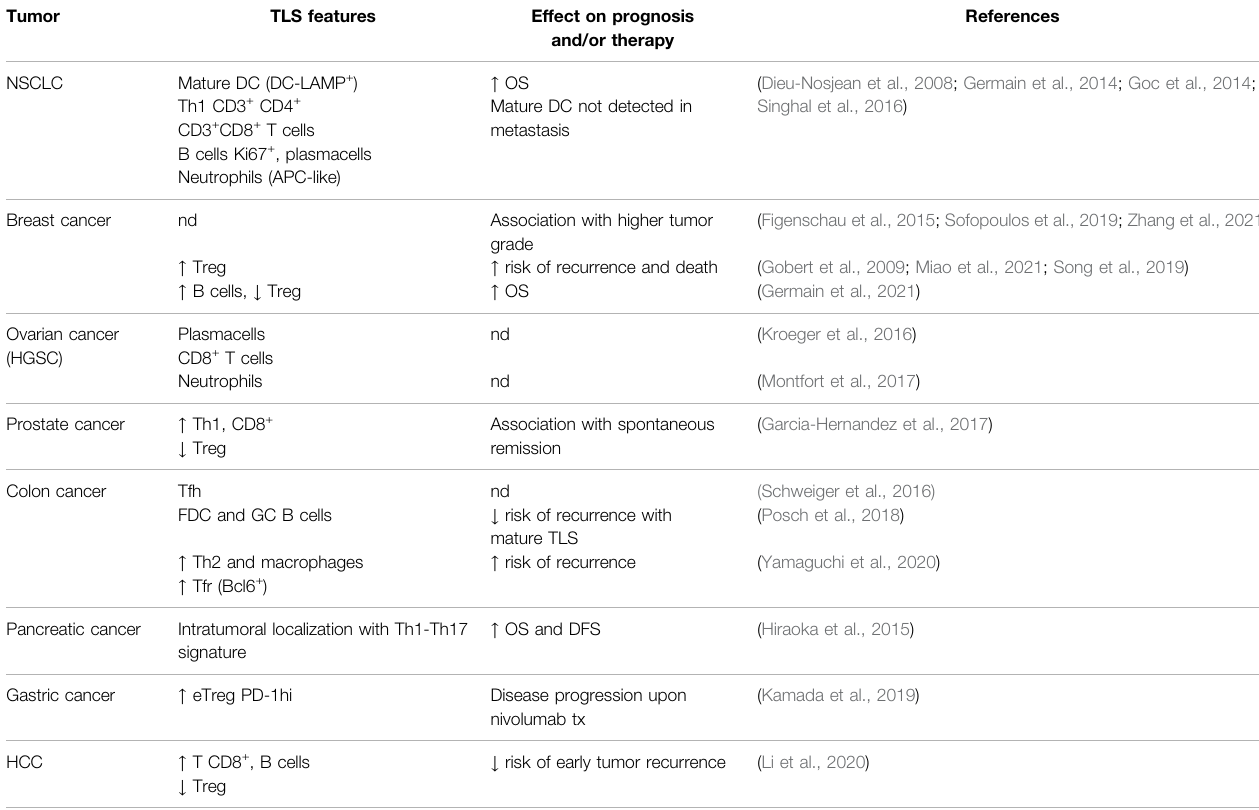
TABLE 1 | TLS features in human cancers and effects on prognosis and/or